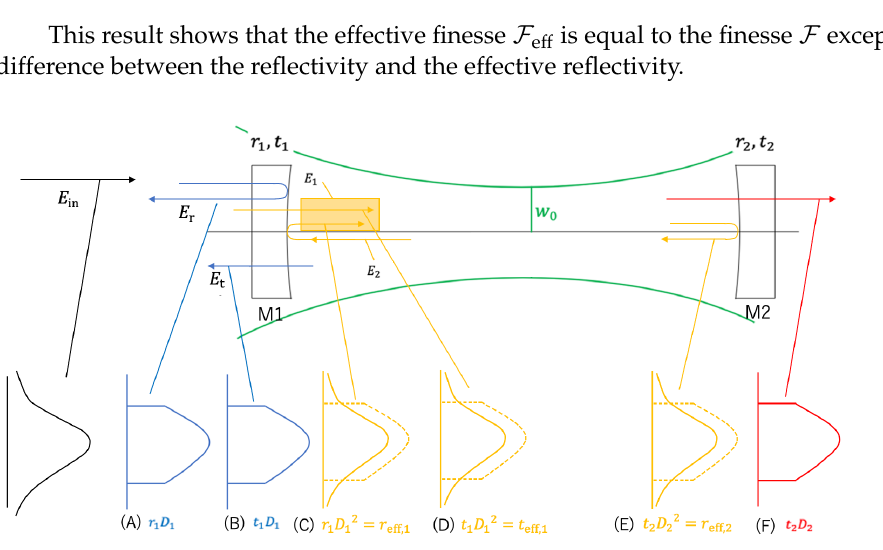
Figure 3. Illustration of each electric fields at each point around the FP cavity when the electric field E in enters the input mirror (M1) together with the transverse shape of the laser field at each point. E 1 is the electric field which is the sum of E in through M1 and goes back and forth n times in the FP cavity. E 2 is E 1 , which is reflected by M2 and goes back and forth once. E t is the fraction of E 2 transmitted by M1. E r is the fraction of E in reflected by M1. Locations outside the cavity, ( A , B , F ), are affected by the leakage loss. Locations inside the cavity, ( C , D , E ), are affected by both leakage loss and higher-order mode